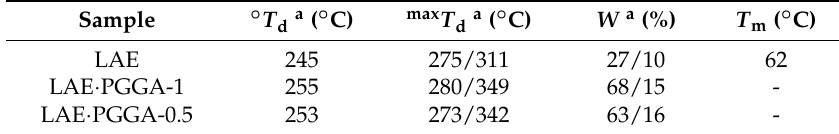
Table 2. Thermal parameters of LAE·PGGA complexes.